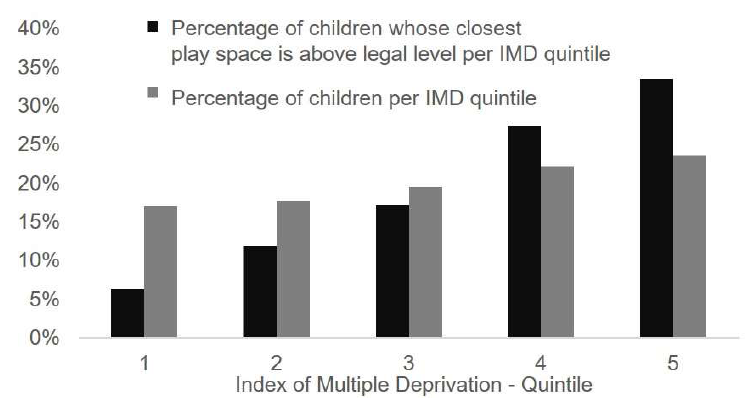
Figure 5. Percent of children in Greater London per Index of Multiple Deprivation quintile (grey) and percentage of children per Index of Multiple Deprivation quintile whose nearest play space exceeds the limit for NO 2 (black).